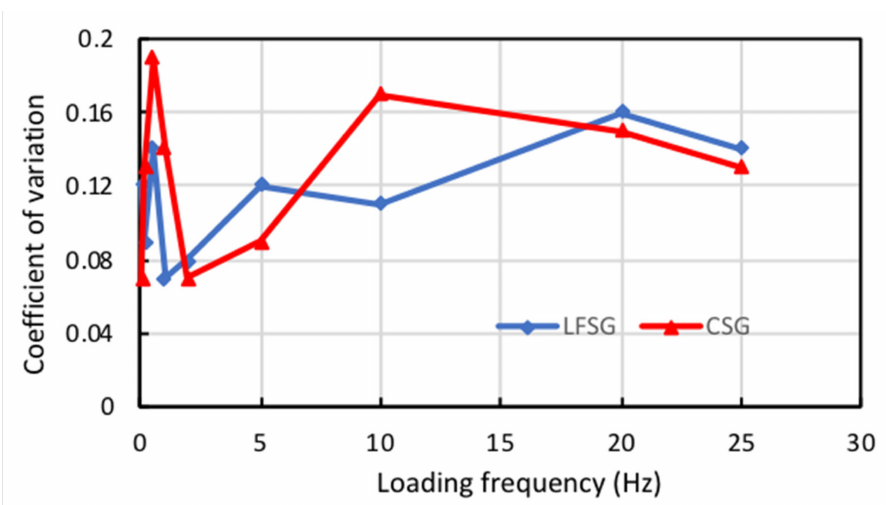
Figure 5. Coefficient of variation of dynamic modulus for CSG and